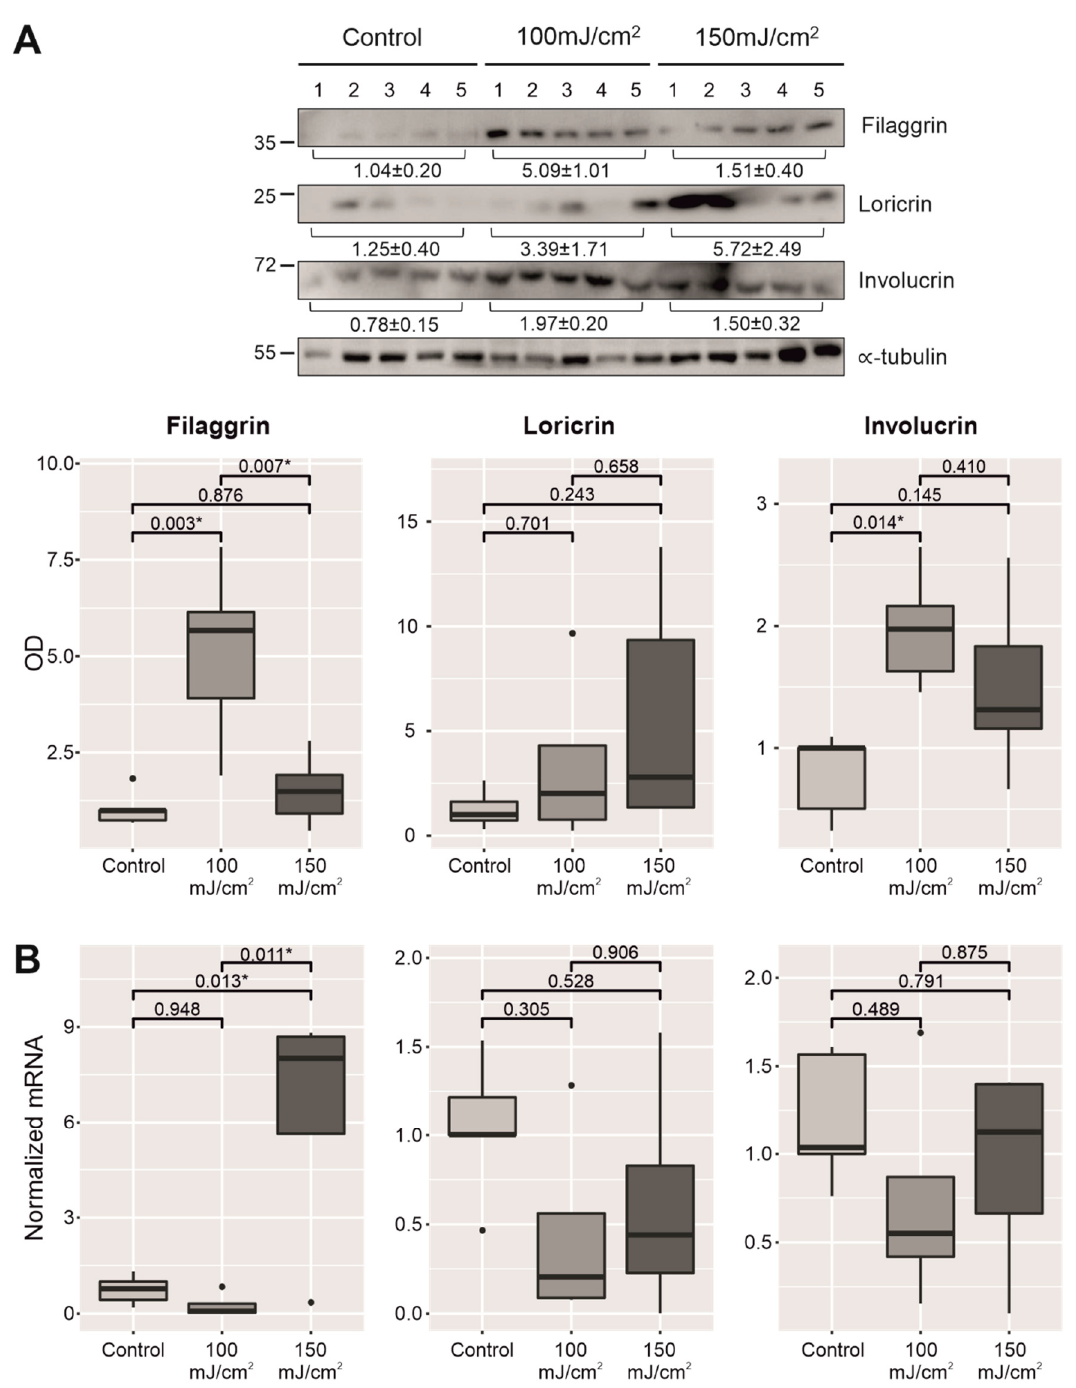
Figure 4. Comparative protein expression of the main differentiation markers linked to the permeability barrier (filaggrin, loricrin, and involucrin) of two groups exposed to UV-B irradiation, 100 mJ/cm 2 and 150 mJ/cm 2 , with respect to the nonirradiated group ( A ). Below, comparative mRNA relative expression levels of these three genes in UV-B-irradiated skin, 100 mJ/cm 2 and 150 mJ/cm 2 , with respect to the nonirradiated group ( B ). * p < 0.05.